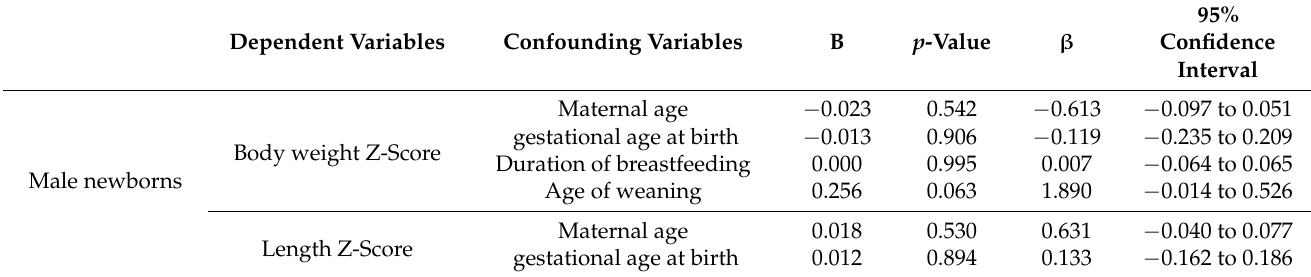
Table 5. Linear regression analysis to evaluate the influence of confounding variables on primary outcome.